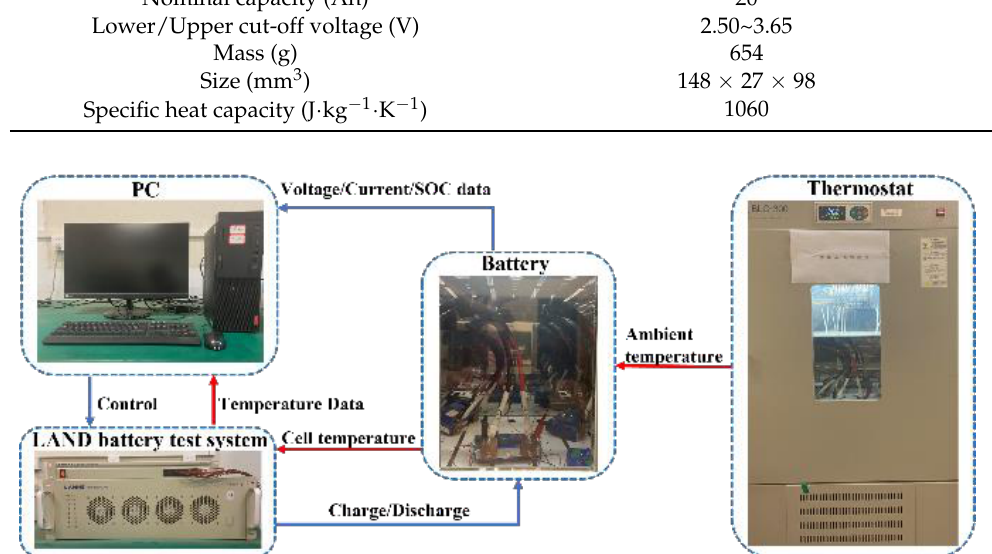
Figure 2. The battery test platform.